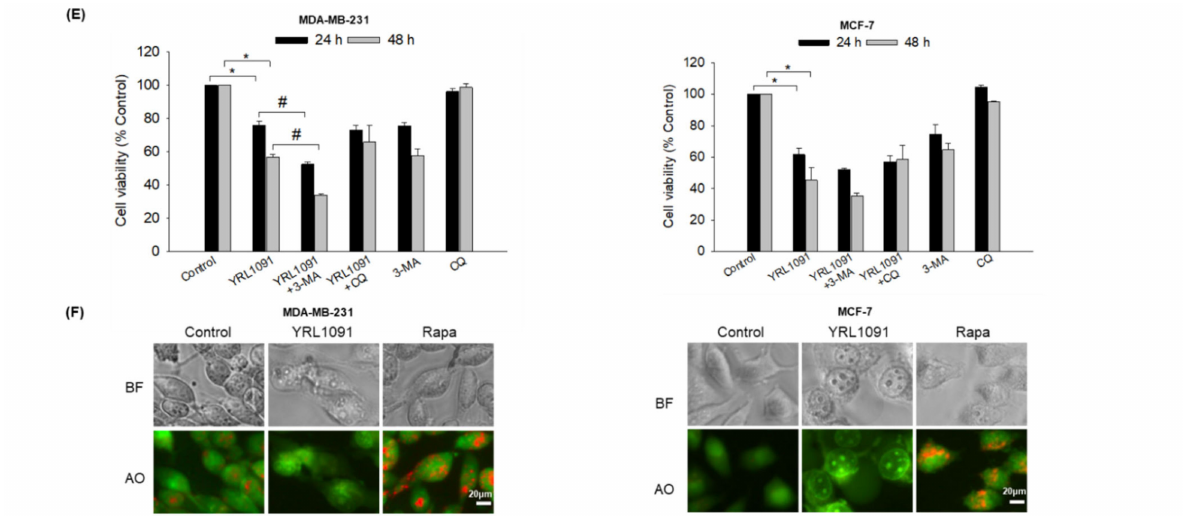
Figure 6. Autophagy-independent features of YRL1091-treated MDA-MB-231 and MCF-7 cells. ( A ) Cells were challenged with 30 µ M YRL1091 for various times (left) or 24 h at the indicated concentrations (right). Levels of p62 were determined by western blotting. ( B – E ) Cells were treated with 30 µ M YRL1091 in the presence or absence of 3-MA (5 mM, pretreatment for 2 h) or CQ (50 µ M, 5 h before cell lysis). Levels of ( B ) LC3B and ( C ) p62 were measured by western blotting. Each data point was calculated as the percentage of protein level in vehicle-treated control cells. Representative blots from at least three independent experiments were shown. ( D ) Vacuolated cells were observed under a microscope. Scale bar: 20 µ m. ( E ) Cell viability at 24 and 48 h was examined by SRB assay. The cell viability of each treated group was expressed as the percentage of that in control group. Data are determined as the mean ± SEM from at least three independent experiments. * p < 0.05 vs. vehicle-treated control cells; # p < 0.05 vs. YRL1091-treated cells. ( F ) Cells were exposed to YRL1091 (30 µ M, 12 h) or Rapa (1 µ M, 6 h), and AO staining was carried out as described in the Materials and Methods. Bright-field (BF) and fluorescent images were provided. Scale bar: 20 µ